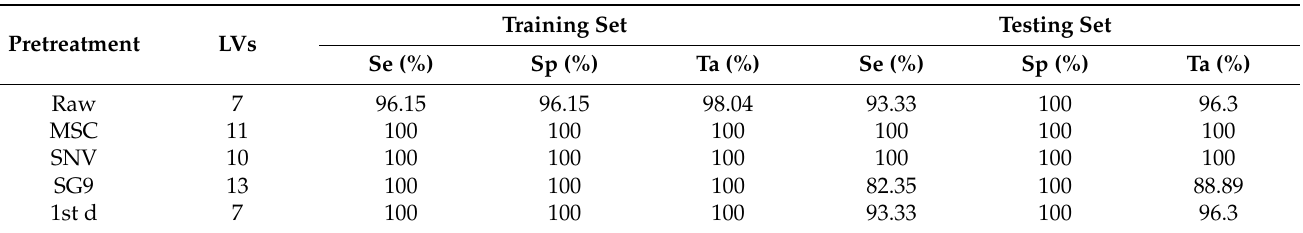
Table 4. The discrimination results of the partial least squares-discriminant analysis models based on low-level data